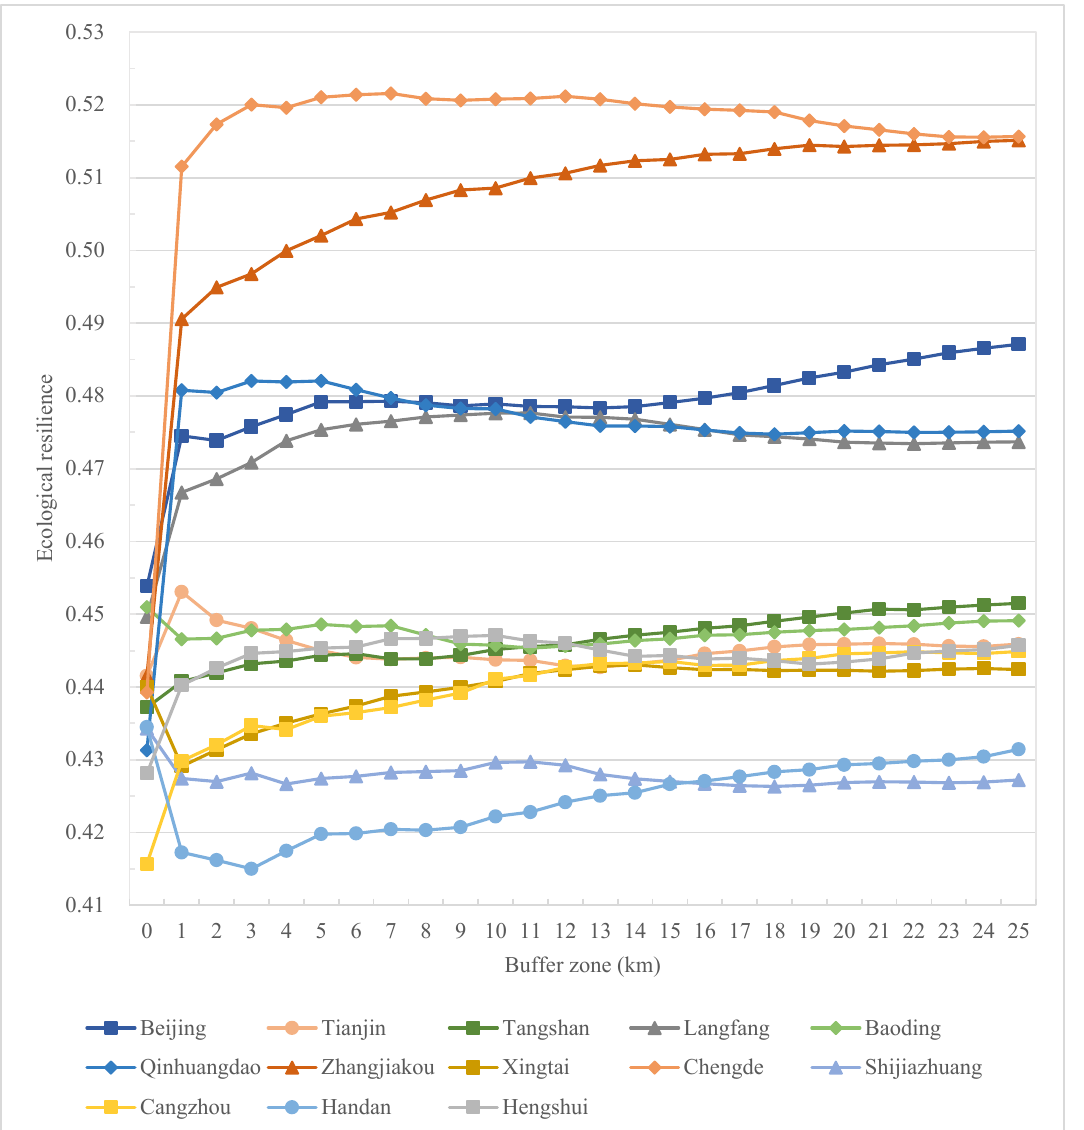
Figure 9. Ecological resilience changes along the urban–rural system at the city level in the BHTUA.